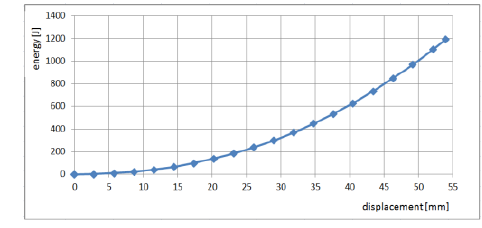
Fig.9 Energy-displacement graphic – model 1 Fig.10 Energy-displacement graphic – model